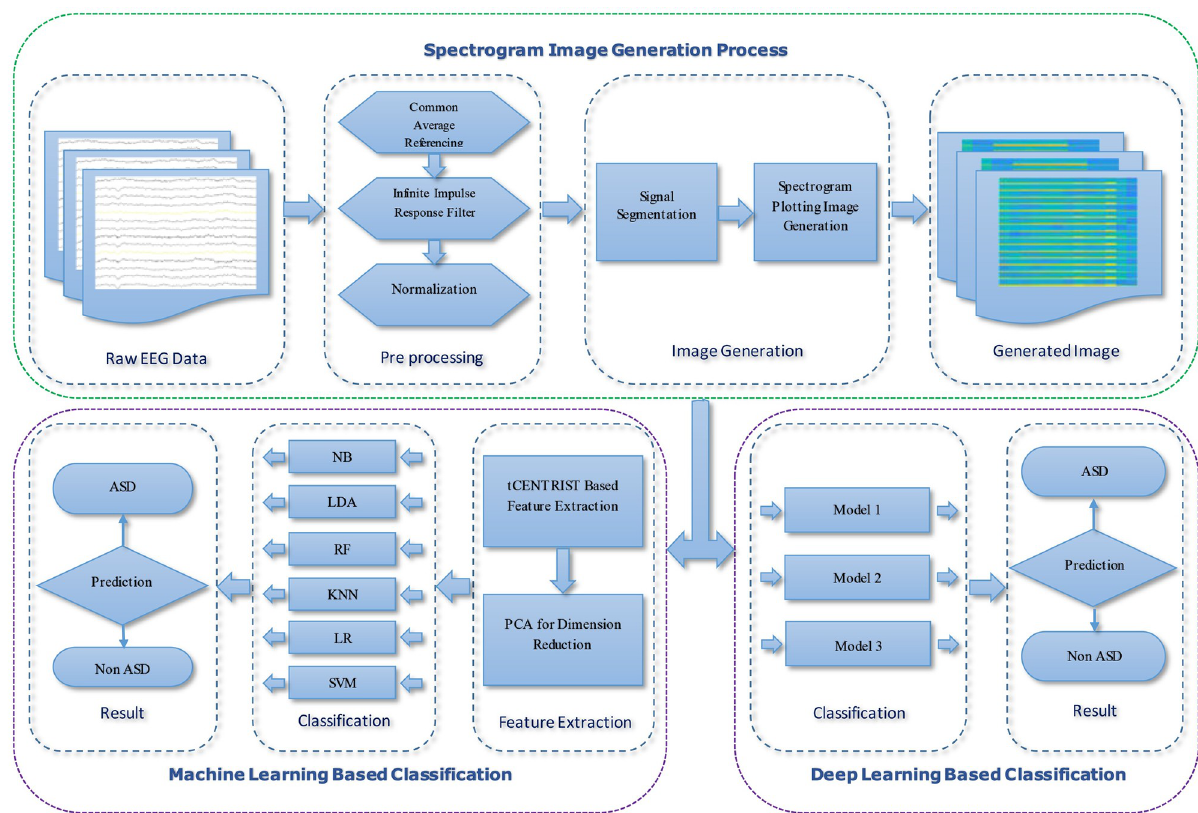
Fig 1. Overview of the proposed